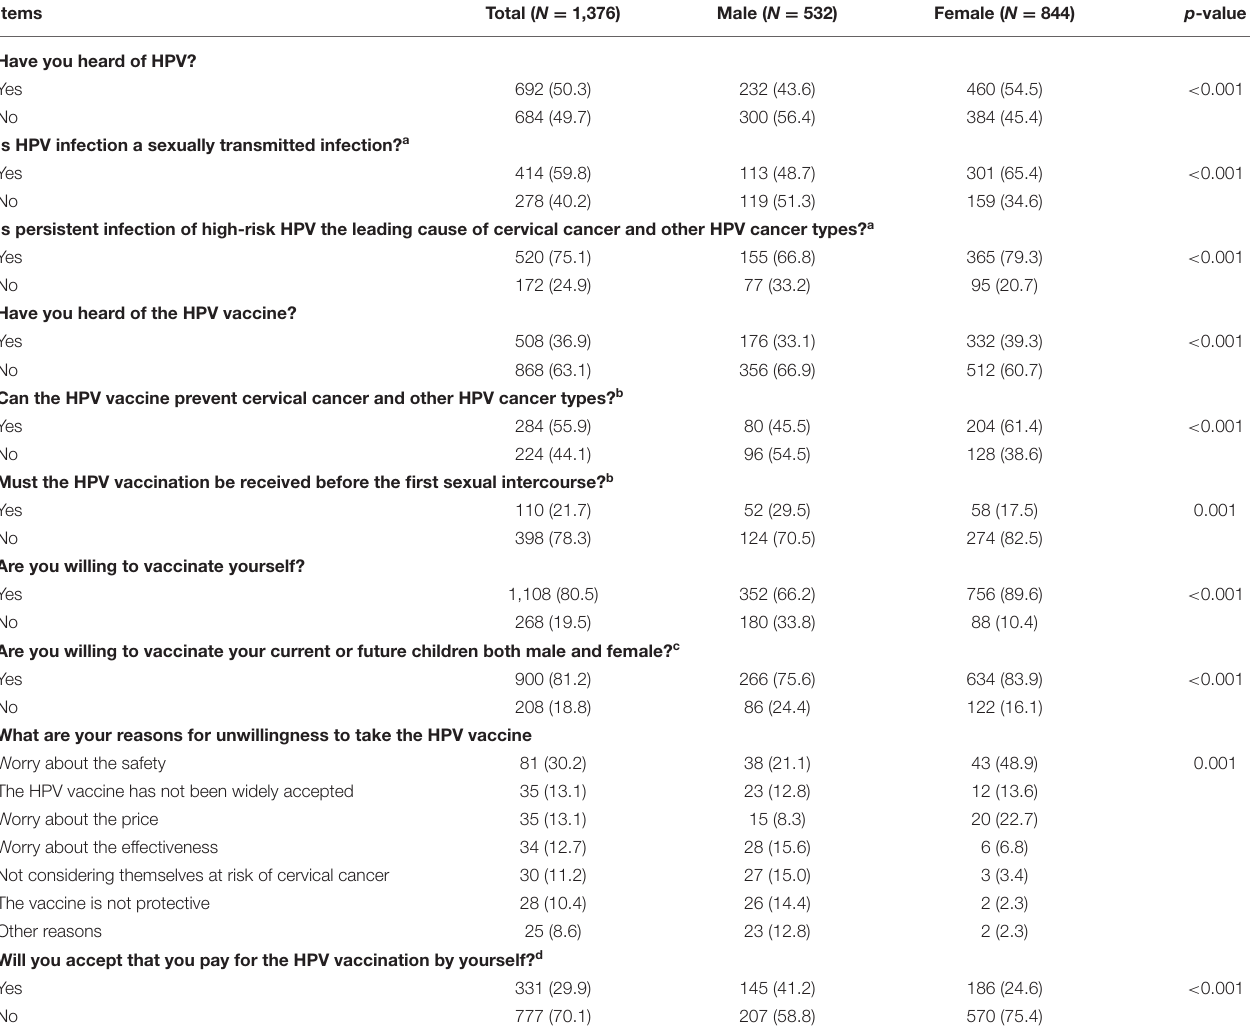
TABLE 5 | Attitude and awareness of HPV and the HPV vaccine among participants. Items Total ( N = 1,376) Have you heard of